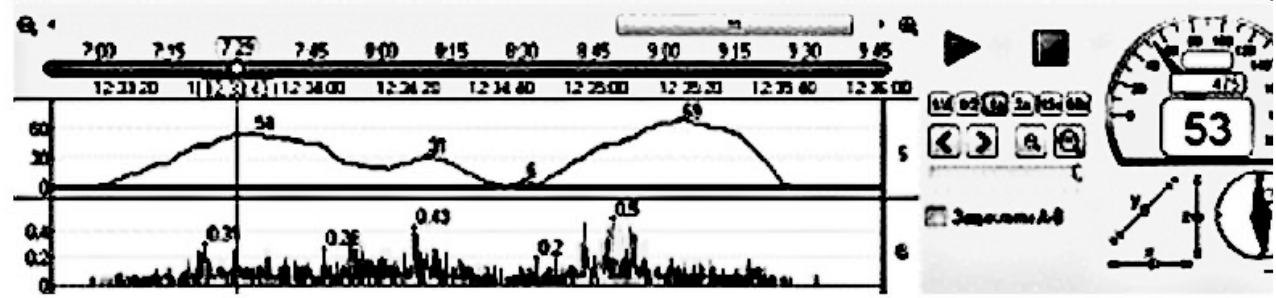
Figure 6. Example of registering fuel consumption and vehicle speed over time in the process of setting up the RegistratorViewer software complex.